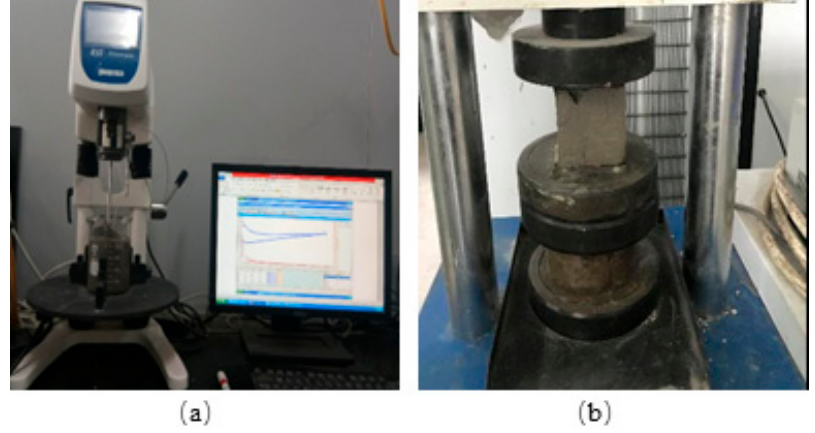
Figure 4. Diagrams of ( a ) rheology tests and ( b ) uniaxial compressive strength tests.